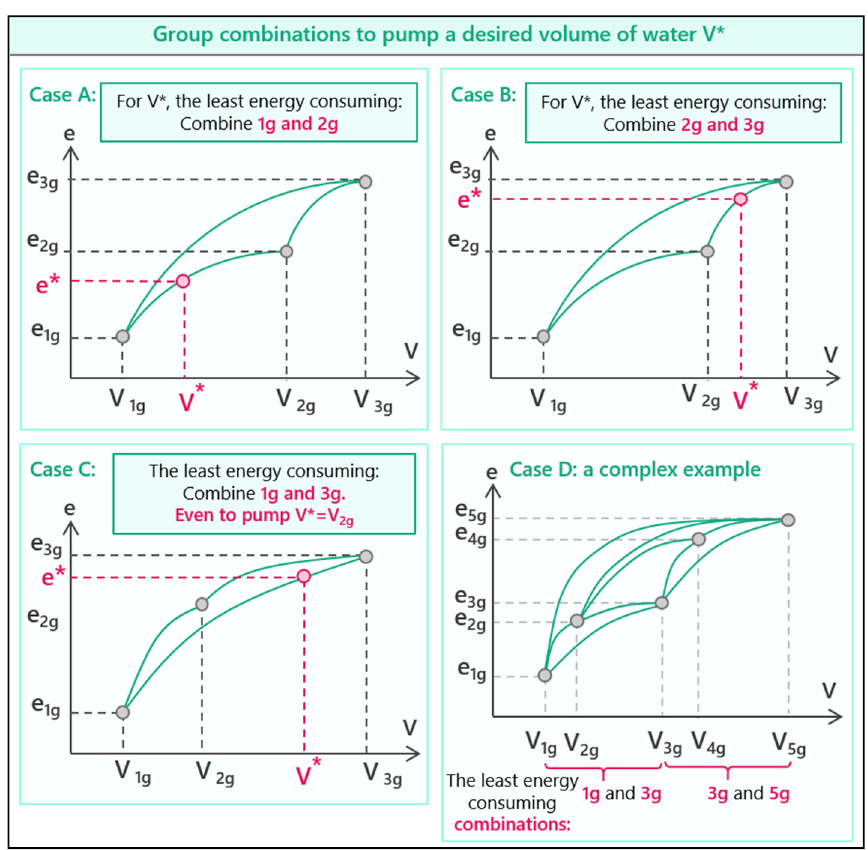
Figure 12. Examples of Convex Hyperbola charts for a pump station.